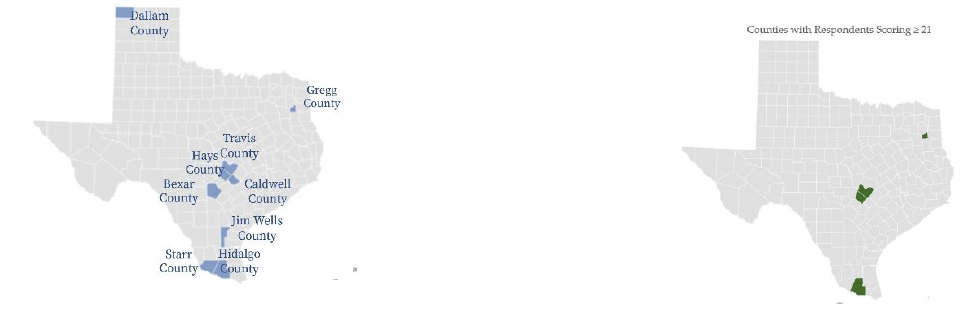
Figure 4. All survey respondent by counties and by counties with scores ≥ 21.